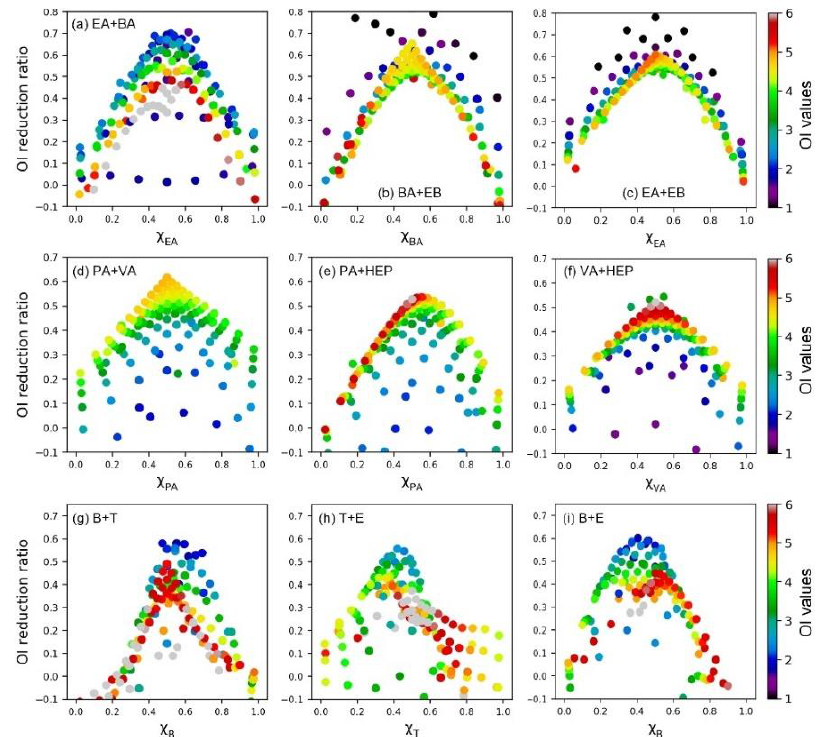
Figure 5. The scatter plot of OI reduction ratio vs. components’ mixing ratio for binary odor mixtures. Colors represent the odor intensity of each sample.